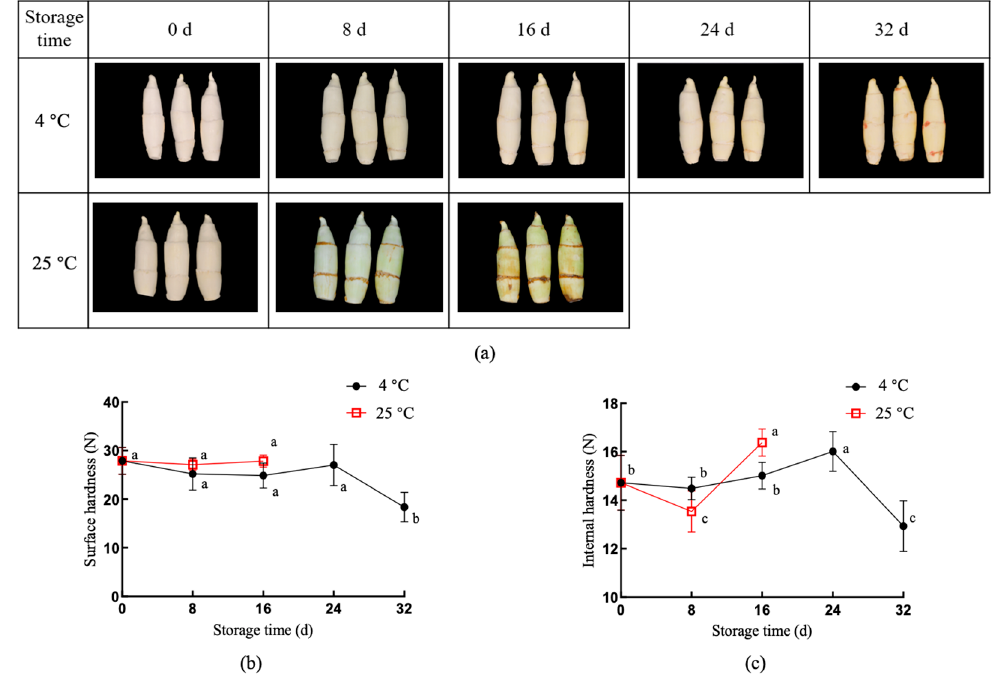
Figure 1. Changes in the hardness of Z. latifolia during storage at different temperatures. ( a ) Images of Z. latifolia shoots stored at 4 ° C and 25 ° C over time indicates changes in physical traits. ( b ) Measurement of surface hardness and ( c ) internal hardness of Z. latifolia shoots stored at 4 ° C and 25 ° C. Each treatment was repeated 12 times. The bars showed the standard deviations of the mean and the letters indicated statistically different for each group by Duncan’s multiple ranges ( p < 0.05) ( n = 12). Different letters in ( b , c ) indicate the significance of differences between groups over time.